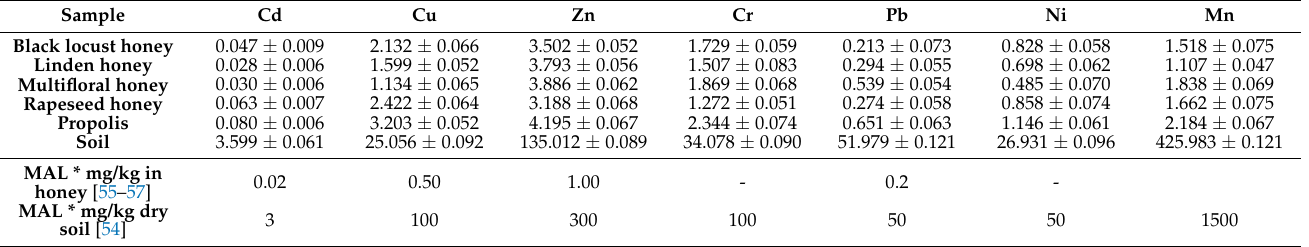
Table 3. Heavy metal concentrations (mean ± standard deviation) (mg/kg) in honey, propolis and soil samples collected from area A1 (area with intense industrial activity).